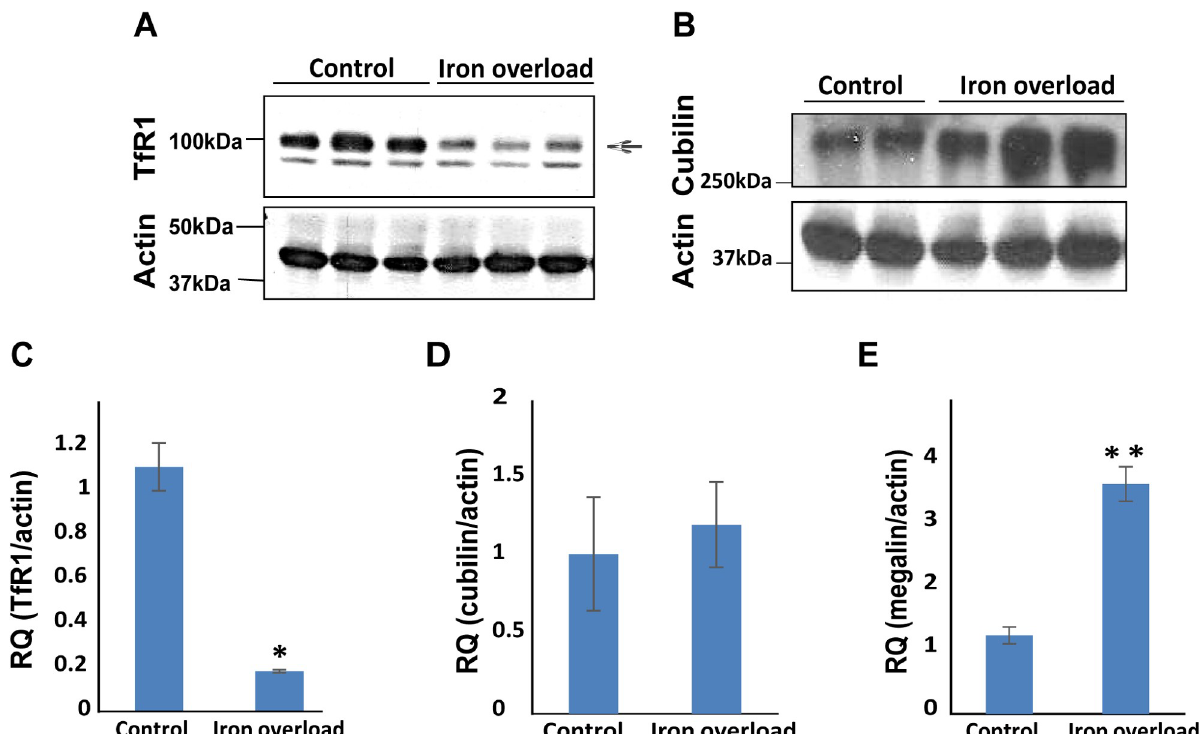
Fig 3. Cubilin and Tfr1 are regulated by iron in opposite directions. TfR1 ( A ) and cubilin ( B ) protein levels were tested by Western-blot analysis of kidney lysates. Membranes were probed with either cubilin, TfR1 or actin antibodies. TfR1 levels in iron over-loaded mice were decreased. Cubilin levels were increased in kidneys from iron–loaded mice. (C, D and E) Kidney mRNA levels of TfR1, cubilin and megalin were evaluated by qPCR. (C) TfR1 mRNA levels correlated with protein levels ( n = 5, � P < 0.05), (D) no significant difference in cubilin mRNA levels was observed ( n = 6). (E) Megalin mRNA expression increased in iron overloaded kidneys (n = 7, �� p <